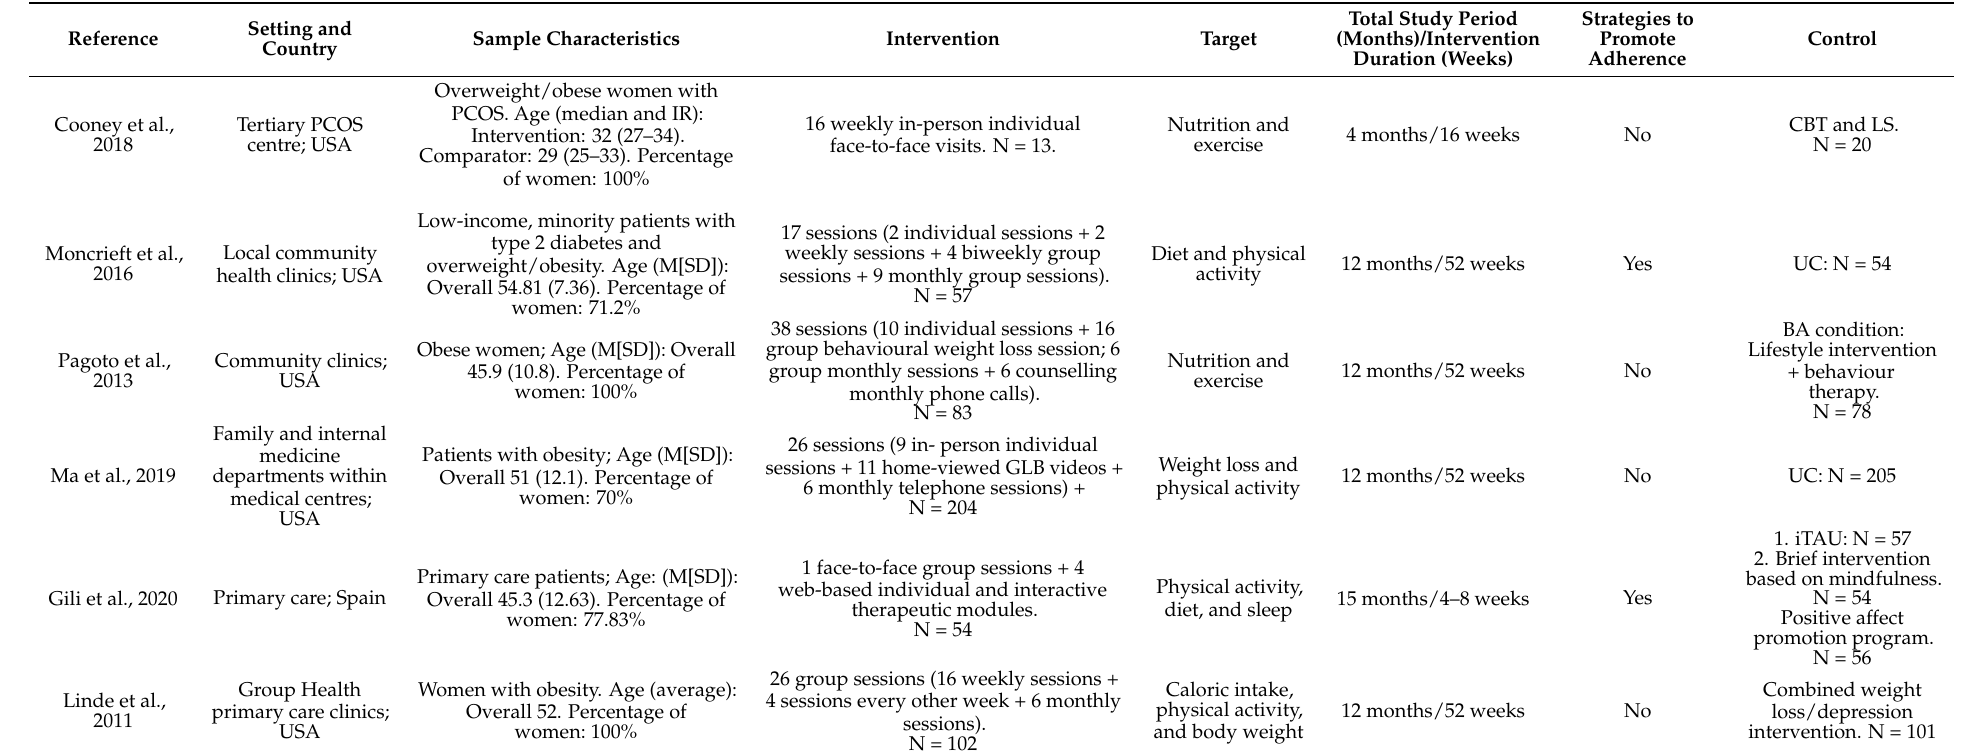
Table 1. Characteristics of the included